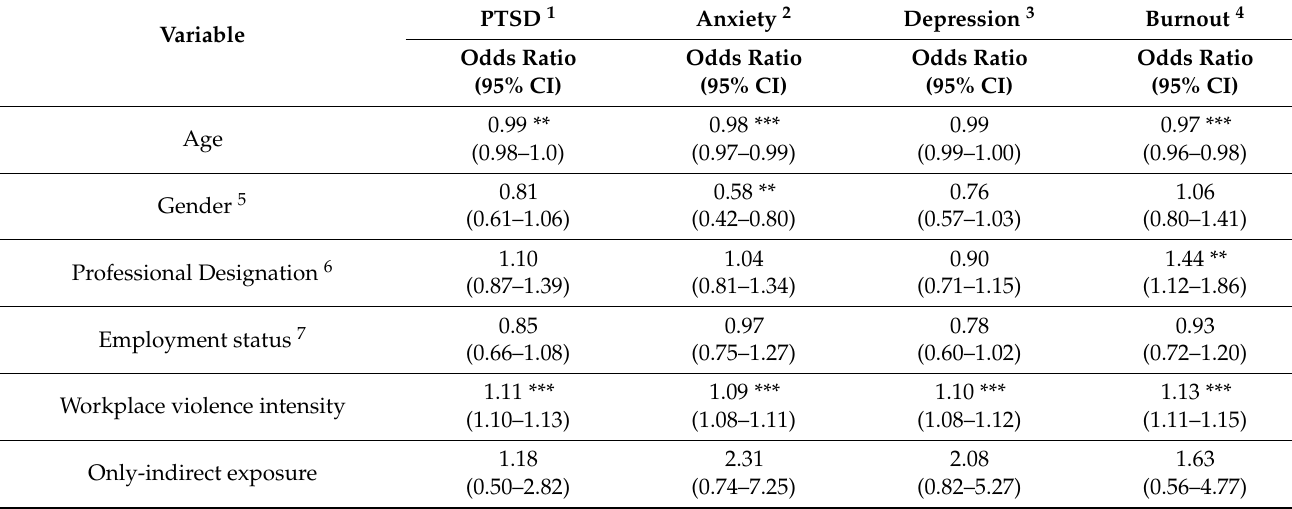
Table 3 shows the logistic regression results. The type of exposure to workplace violence was significantly related to mental-health outcomes after controlling for nurse de- mographics and workplace-violence intensity. Nurses that reported “only direct exposure” and “both direct and indirect exposure” were two to four times more likely to meet the criteria for PTSD ( OR = 2.18–3.11, p < 0.01), anxiety ( OR = 3.49–3.85, p < 0.01), depression ( OR = 2.02–2.33, p < 0.05) and burnout ( OR = 2.51–3.39, p < 0.01) compared to the “no exposure” group. Indirect exposure alone was not related to any of the mental-health outcomes in this study. Table 3. Binary logistic regression on workplace violence exposure type predicting mental health outcomes ( N = 2958). PTSD Variable